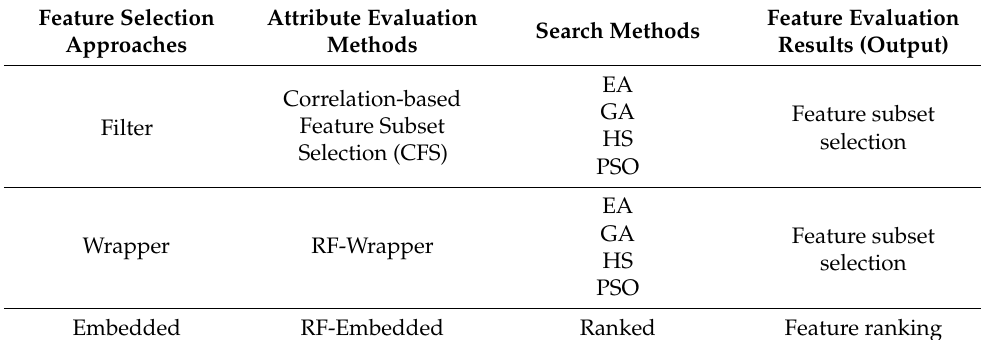
Table 2. List of feature evaluators.